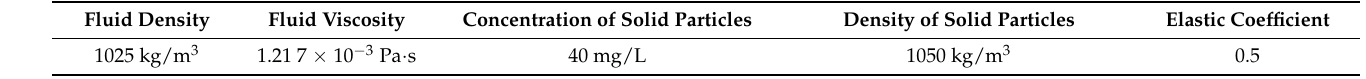
Table 2. Solid particle parameter